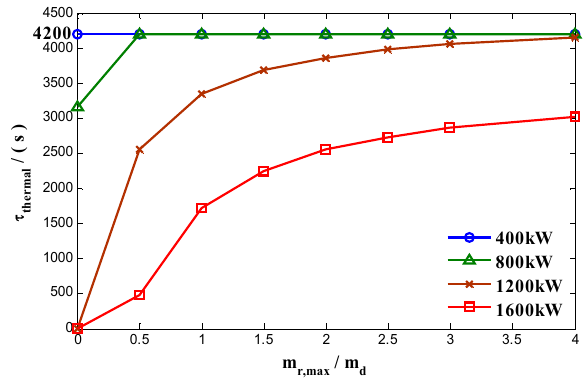
. / m   on τ thermal . Figure 5. Influence of . m m d on τ thermal ,max r r ,max /